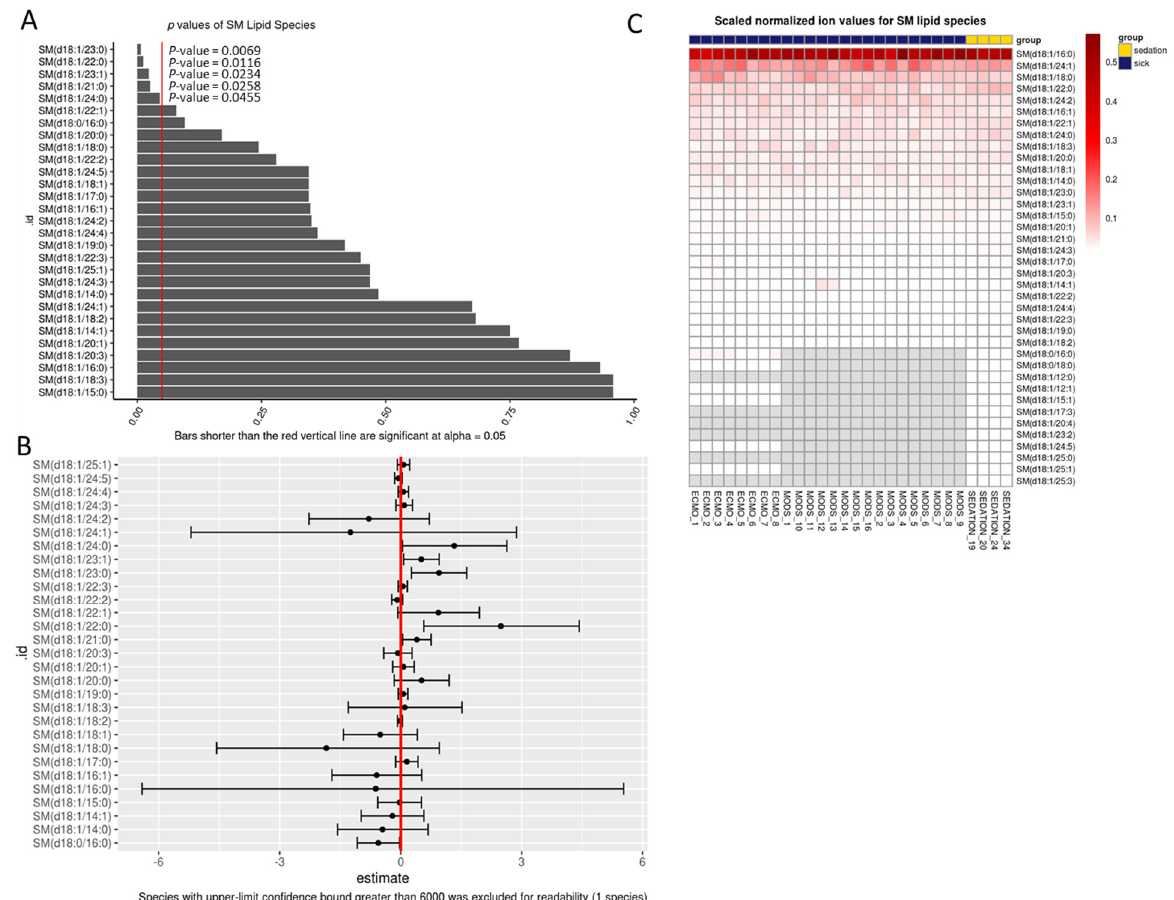
Figure 1. Percent total sphingomyelin lipid species at baseline. ( A ) Bar chart of p -values from regression output from log-transformed data; red line indicates 0.05. Any p -value that crosses 0.05 is not statistically significant. ( B ) Points in B represent the mean log(fold-change) in odds between sick and sedation groups. The error bars in B, represent the upper and lower bounds of the false-coverage for the estimate. 95% false coverage intervals of the mean log (fold-change) in odds; red line indicates 0. Any confidence interval that crosses 0 is not statistically significant. ( C ) Scaled values of total lipids based on absolute normalized ion abundances per ml of plasma; SM: